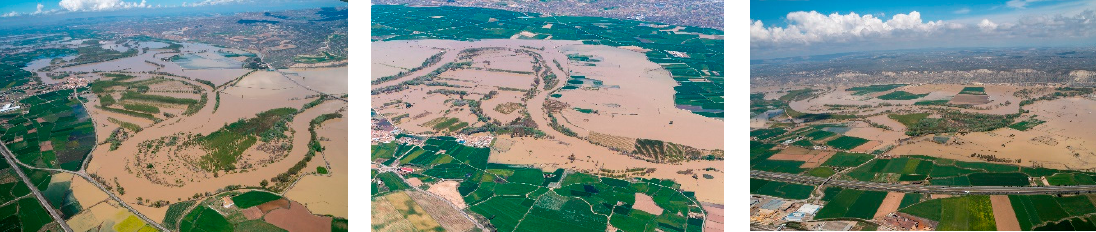
Figure 7. Aerial views of the study area on 14 April 2018, showing the flood of the Ebro and the characteristic riverbank vegetation as highly flooded (Source: CHE, 2018 [36]).